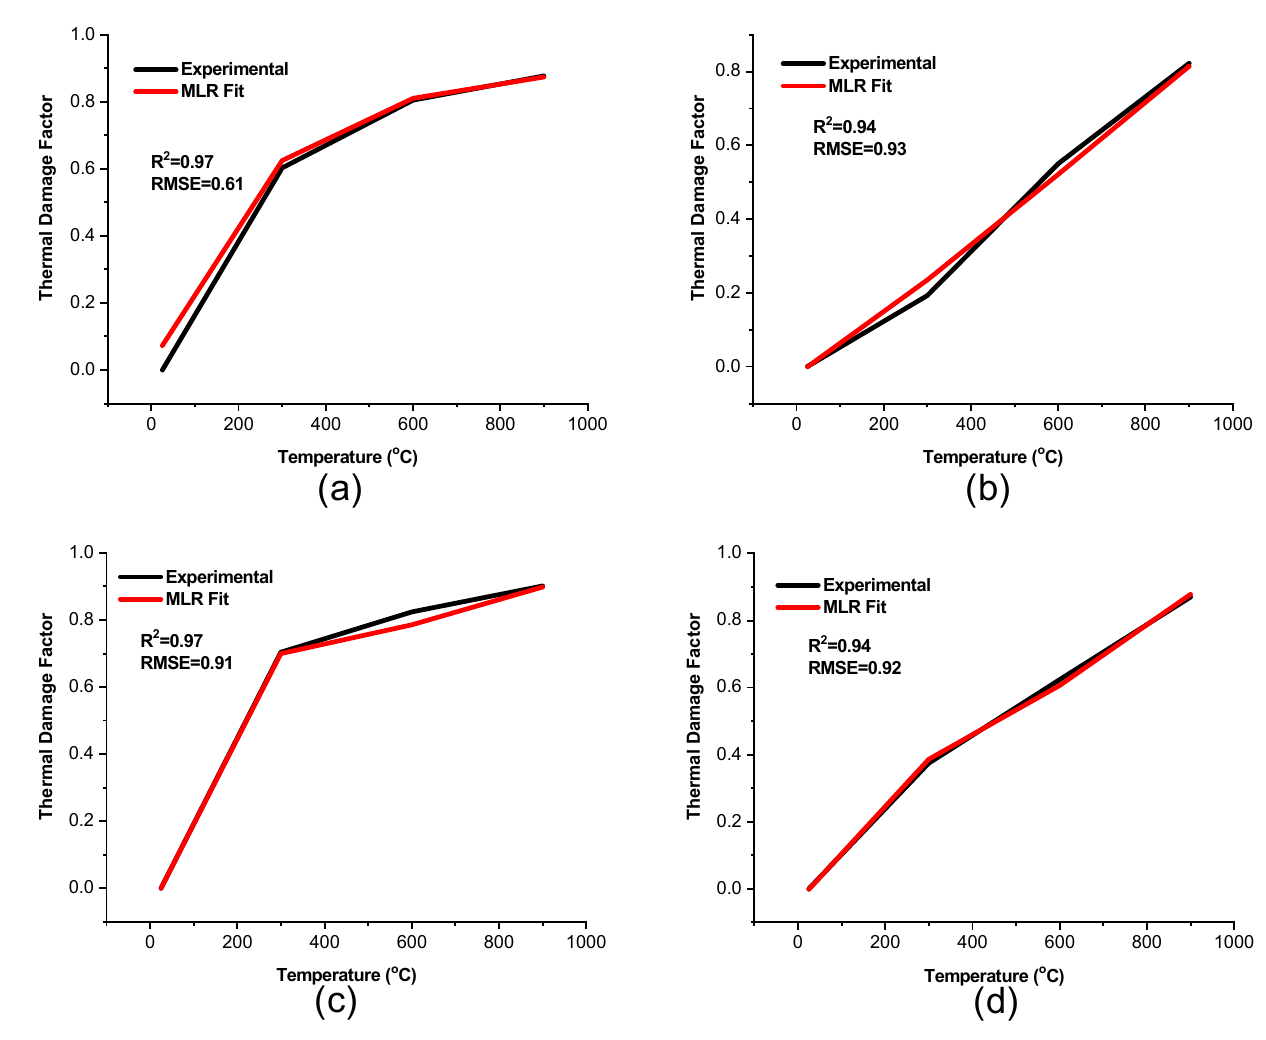
Figure 3. Experimental and MLR models; ( a ) porosity-based D T under slow cooling; ( b ) elasticity- based D T under slow cooling; ( c ) porosity-based D T under rapid cooling; and ( d ) elasticity-based D T under rapid cooling.